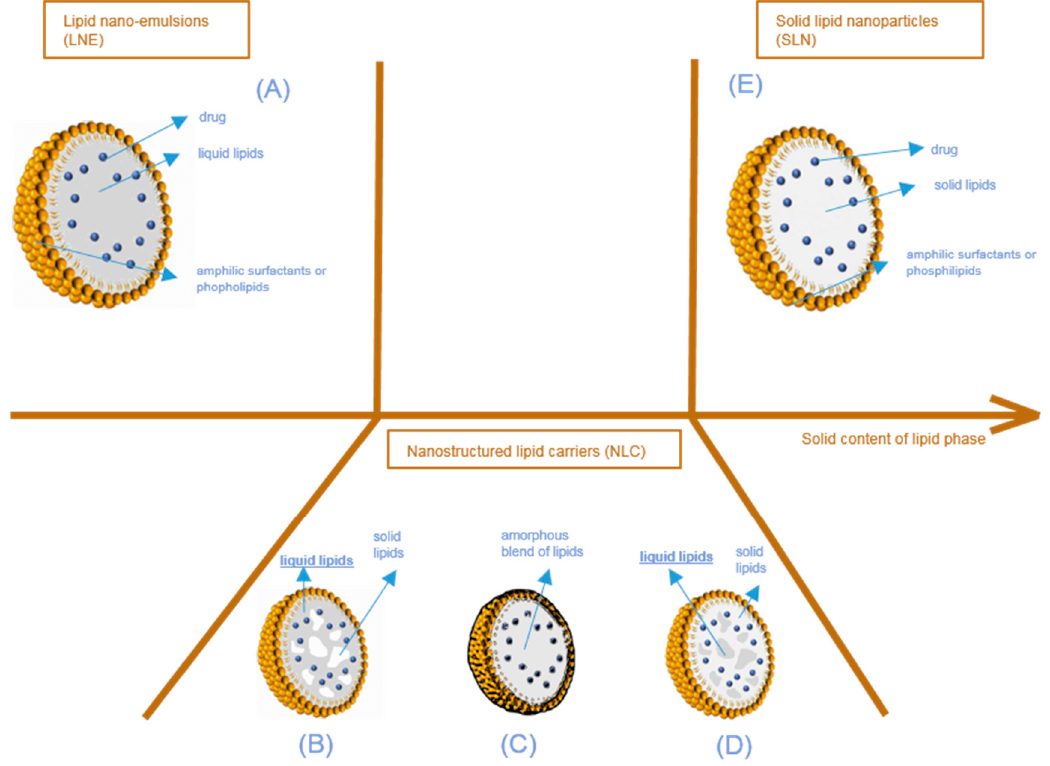
Figure 2. Structure of lipid nanoparticles according to the physical state of the lipid core, from lipid nano-emulsions ( A ) to solid lipid nanoparticles ( E ), through nanostructured lipid carriers ( B – D ). Different types of nanostructured lipid nanocarriers are possible according to the physical state of the blend of liquid and solid lipids composing the particle core (solid pockets in liquid ( B ), amorphous blend ( C ), liquid pockets in solid ( D